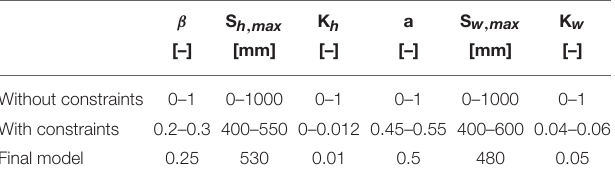
TABLE 2 | Parameters distributions before calibration, after calibration and after imposing constraints. β S h ,